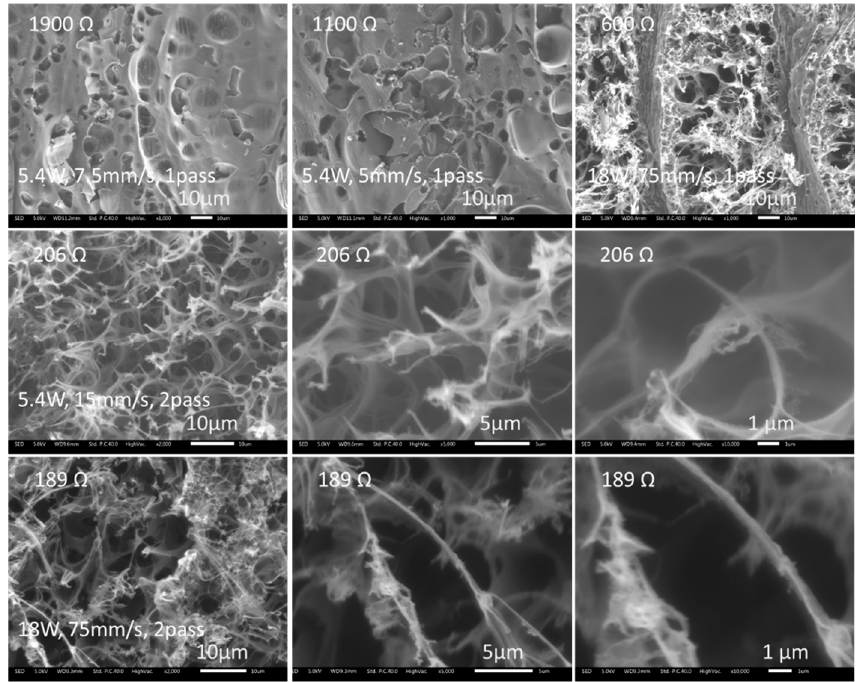
Figure 9. High magnification SEM images showing the porous structure transition to feather structure together with fiber structures with decreasing electrical resistance.